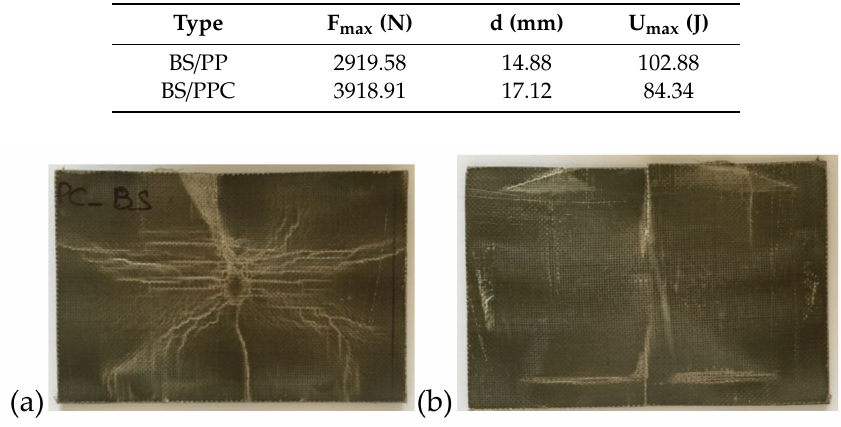
Figure 5. Impacted PPC basalt samples at penetration: ( a ) Front; ( b ) back.